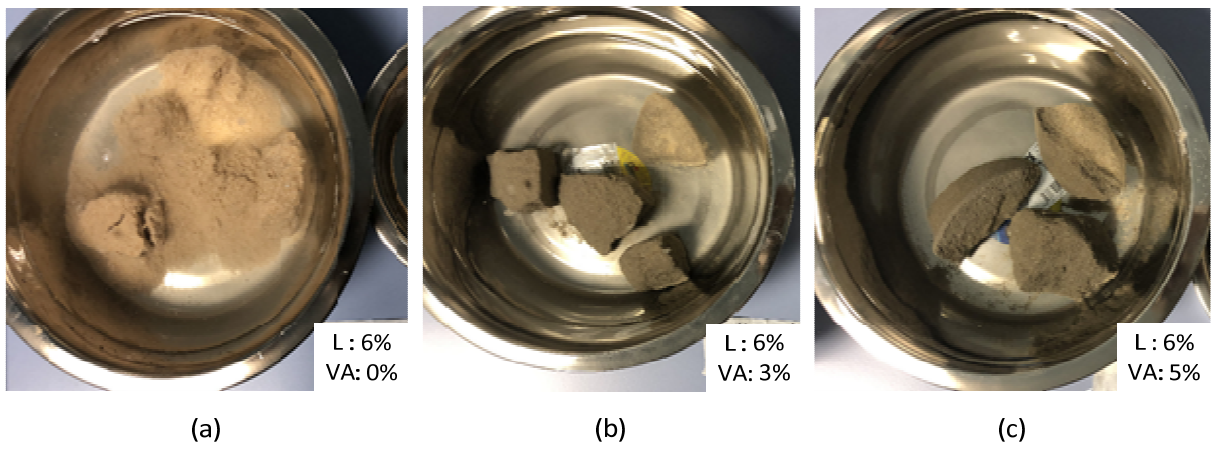
Figure 11. ( a ) UCS-test, ( b ) CBR test, and ( c ) CBR-tested sample.